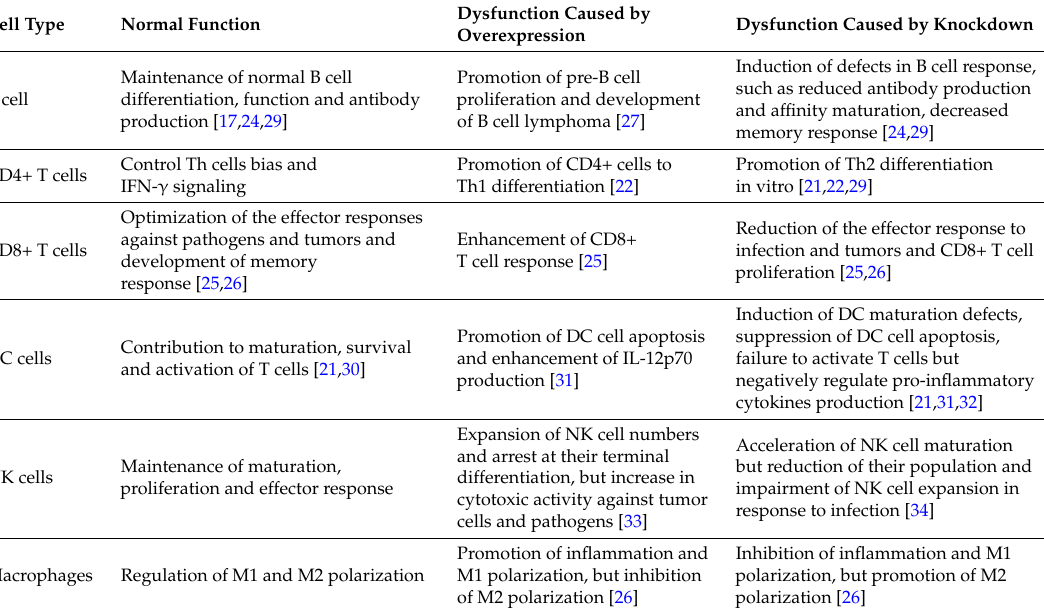
Table 1. Function and abnormalities of miR-155 in different types of immune